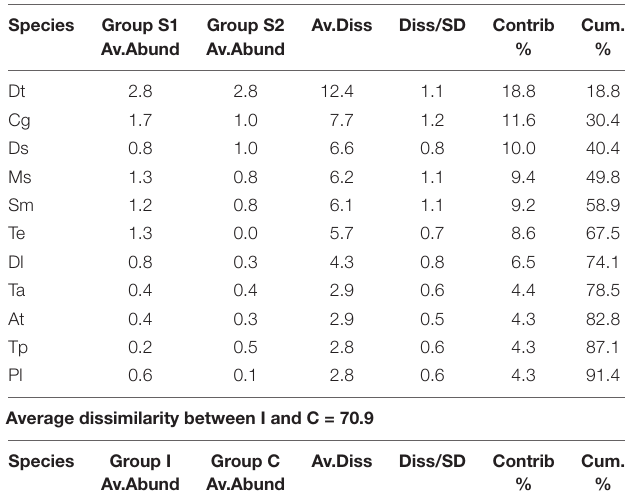
TABLE 4 | Simper table of the molluscs species that most differentiated the two periods (2017 and 2018) and the two treatments: Impact (I) and Control (C). Average dissimilarity between S1 and S2 =